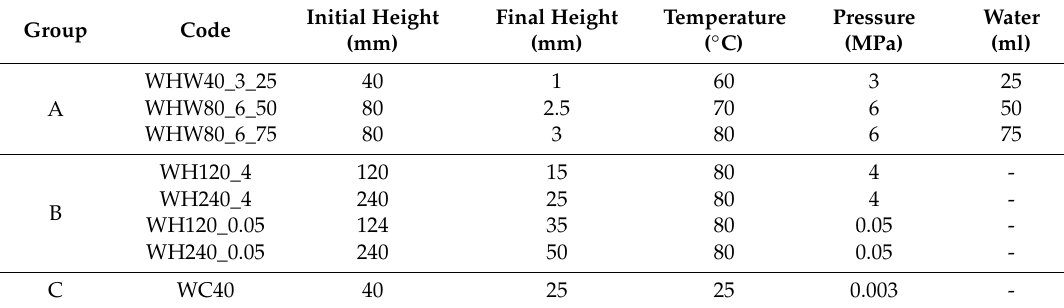
Figure 3. Groups of obtained materials. Table 1. Technical parameters of the materials obtained.